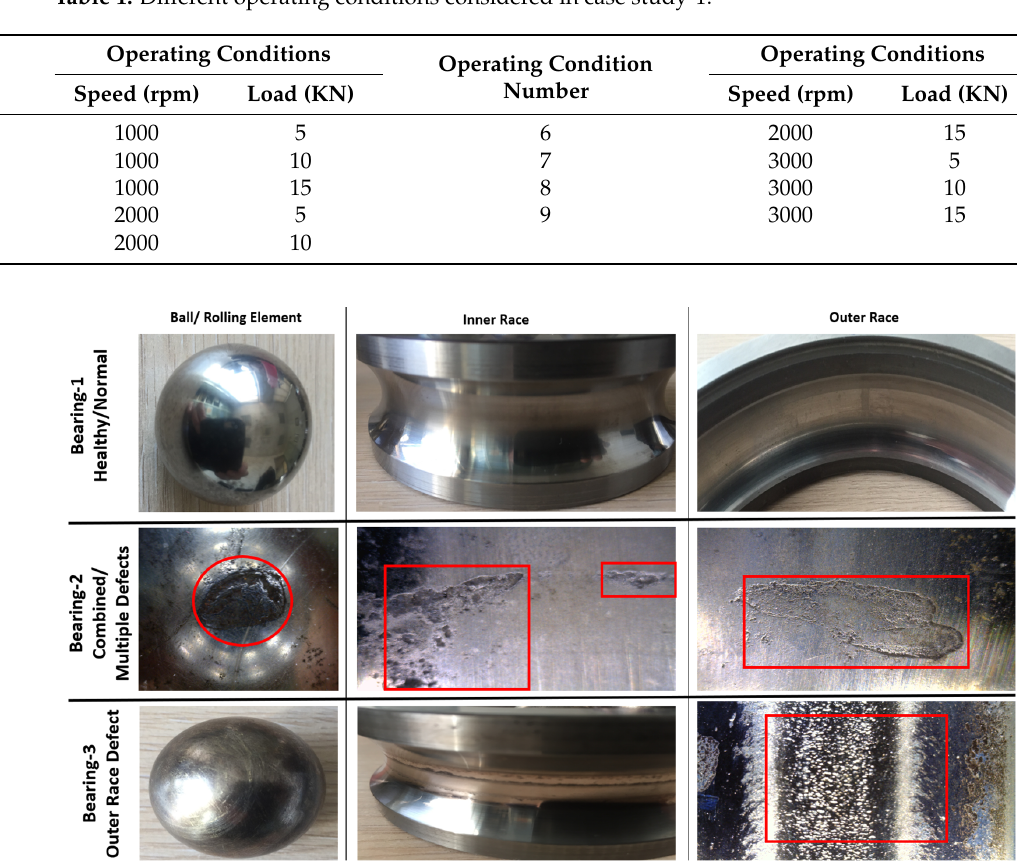
Figure 6. Test rig-1 layout. Table 1. Different operating conditions considered in case study-1.